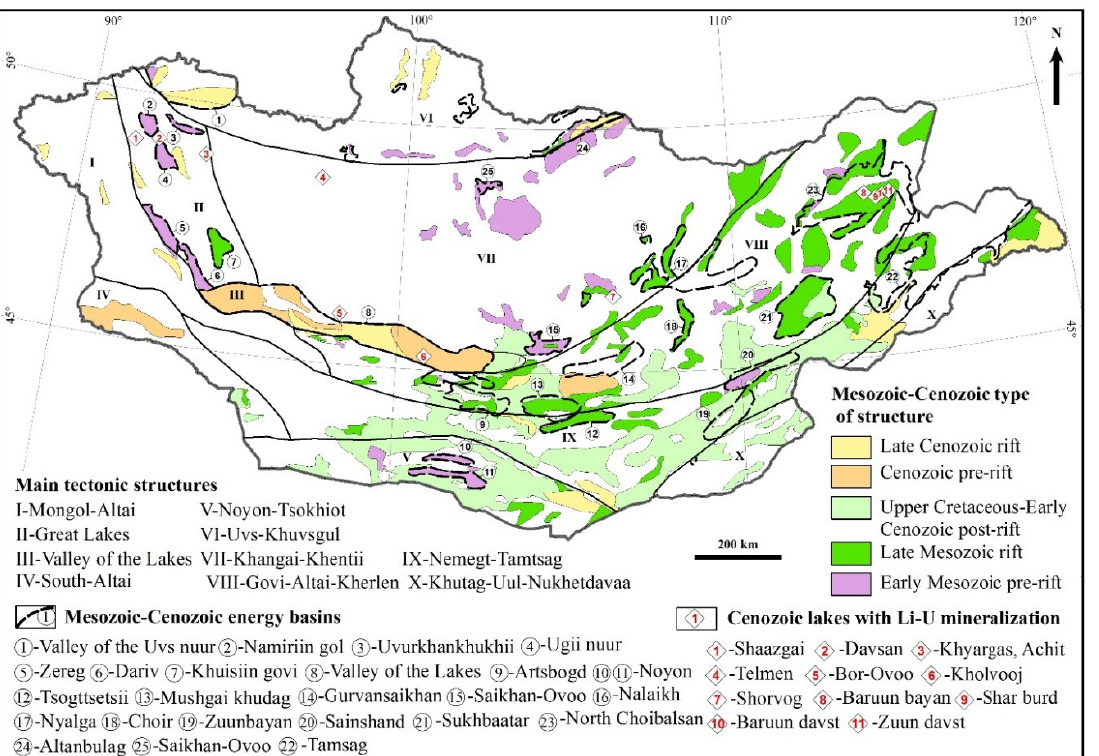
Fig. 1. Distribution of energy basins and main Mesozoic - Cenozoic tectonic structures (After Badamgarav et al.,